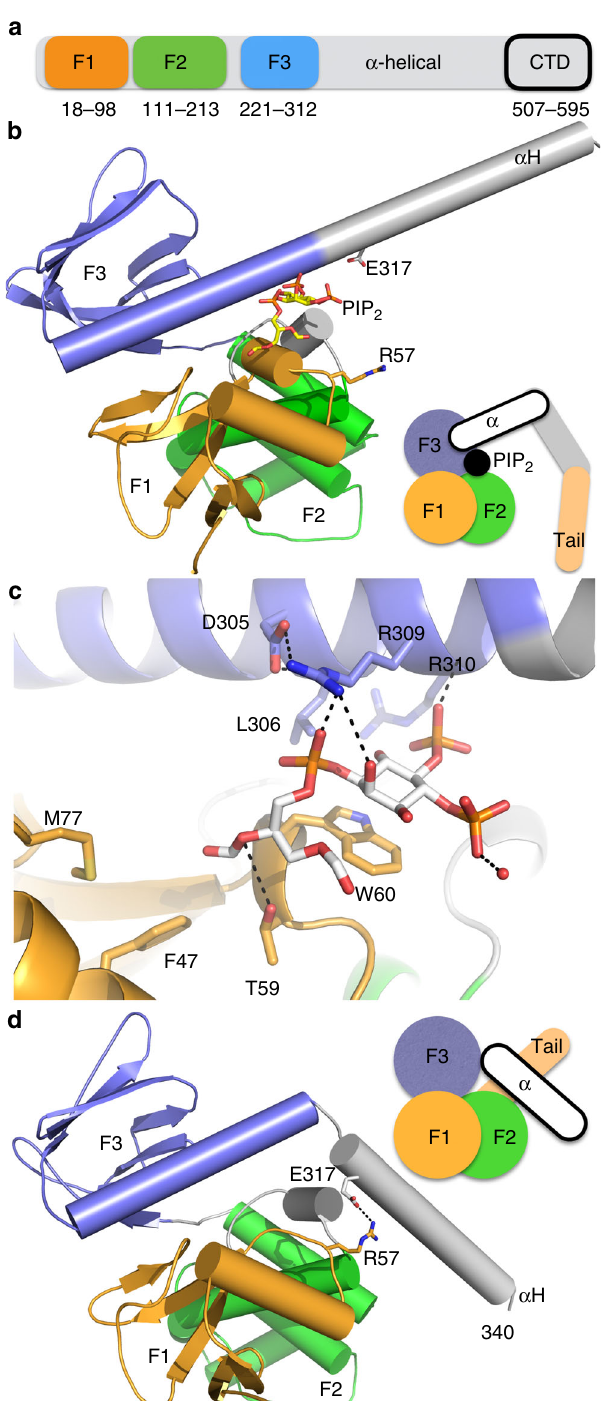
Fig. 1 Lipid binding to neuro fi bromin 2 causes major conformational changes. a Schematic depiction of the domain organization of full-length neuro fi bromin 2. The F1, F2, and F3 FERM subdomains and the C -terminal domain (CTD) are indicated that are connected by the central α -helical domain. b The 2.61 Å PIP 2 -bound neuro fi bromin 2 structure. The F1 subdomain (residues 18 – 98) is shown in light orange, F2 (residues 111 – 213) in green, and F3 (residues 221 – 312) in blue. The α -helix from the central helical domain, α H, is shown in gray (residues 315 – 339). The cartoon illustrates binding of PIP 2 to full-length neuro fi bromin 2 with its head – tail interaction severed. c Close-up view of the PIP 2 binding site. The carbon atoms of PIP 2 are shown in gray, of the neuro fi bromin 2 F1 subdomain in orange, and F3 in blue. Hydrogen bonds are indicated and key binding residues are labeled. d View of the closed FERM neuro fi bromin 2 structure (PDB entry 1isn 34 ) in the same orientation as our lipid-bound structure shown in panel b . The electrostatic interaction between E317 OE2 and R57 NH2 is indicated (and the distance is 2.9 Å) that is severed in our lipid-bound structure shown in b . The cartoon highlights the distinct conformation of α -helix α H from the central